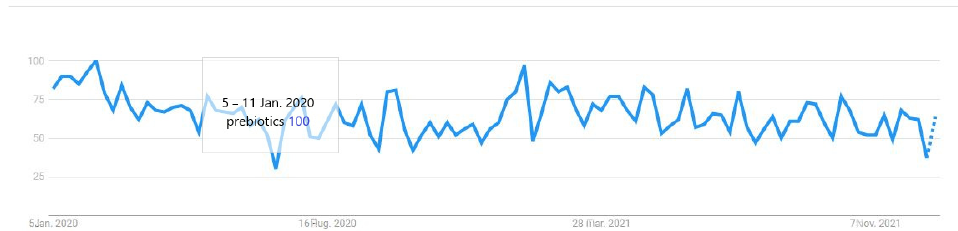
Figure 1. The level of interest in “prebiotics” from December 2019 to December 2021 (https://trends.google.com/, accessed on 06 January 2022).